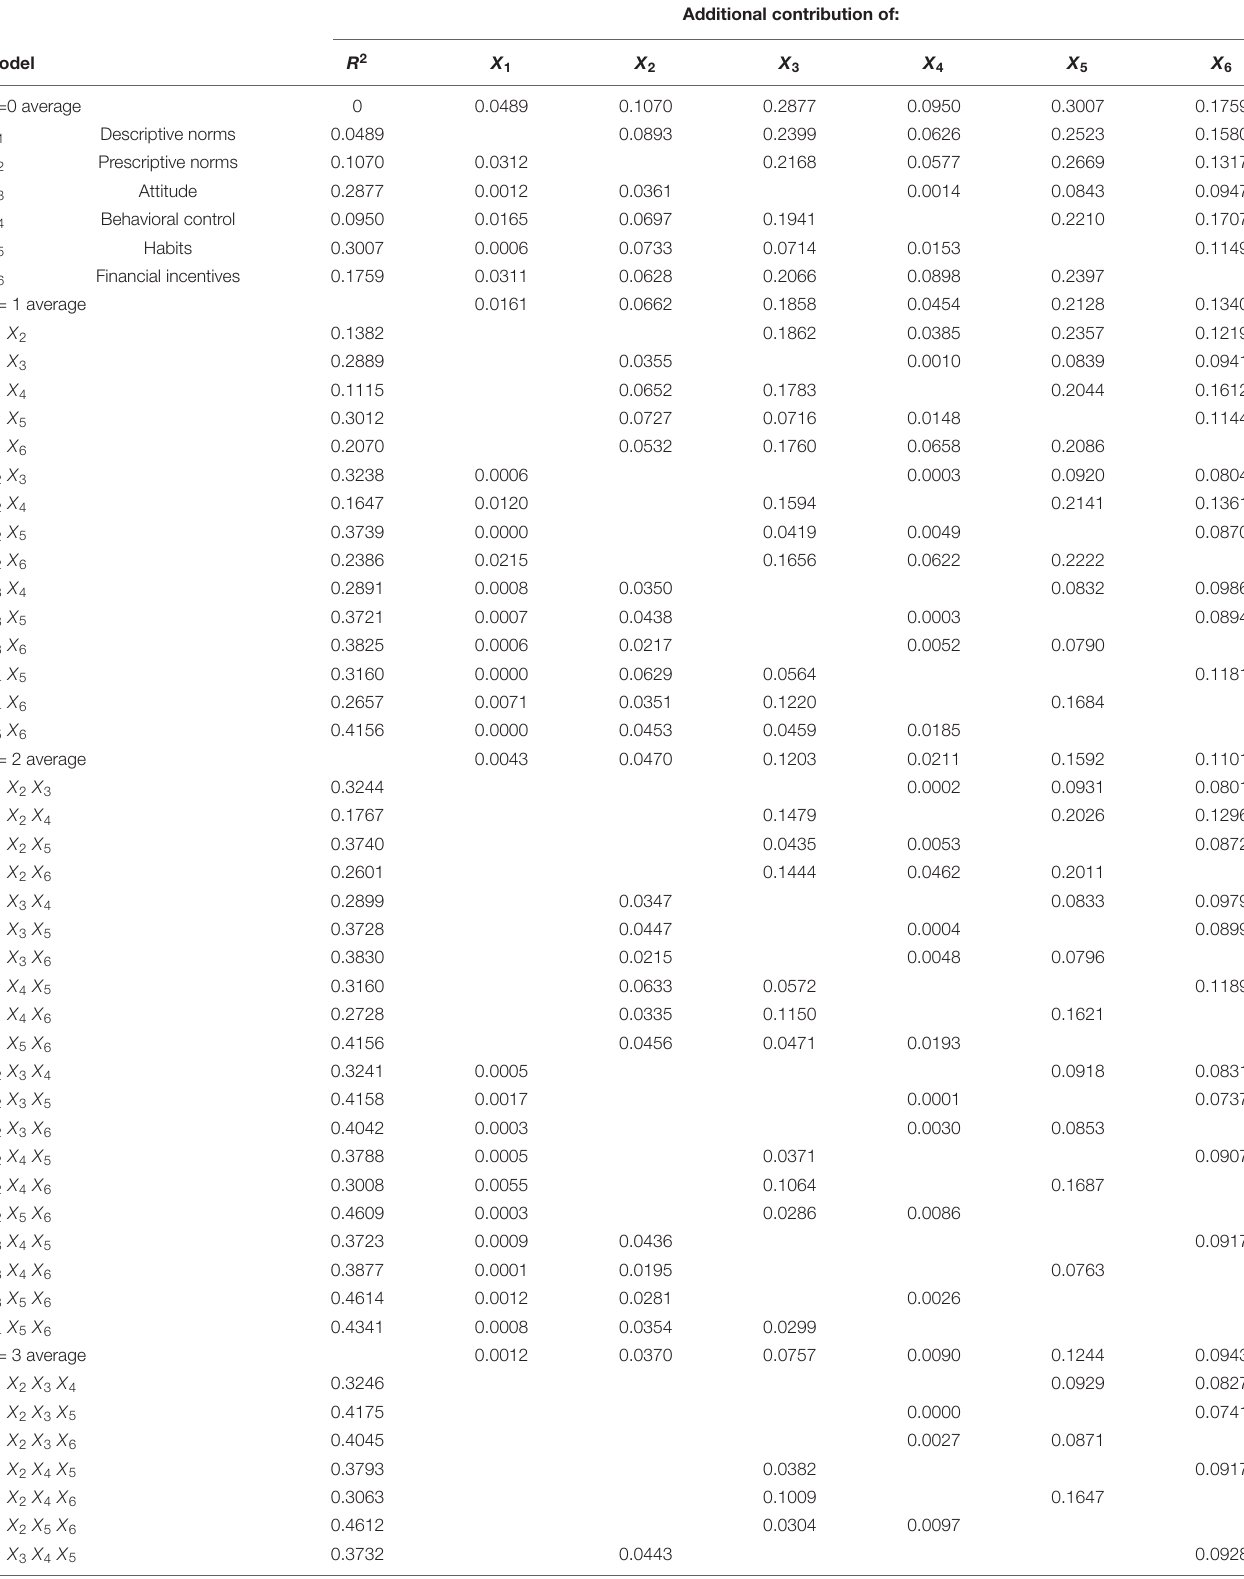
TABLE 2 | Additional contributions of predictors across all subset regression